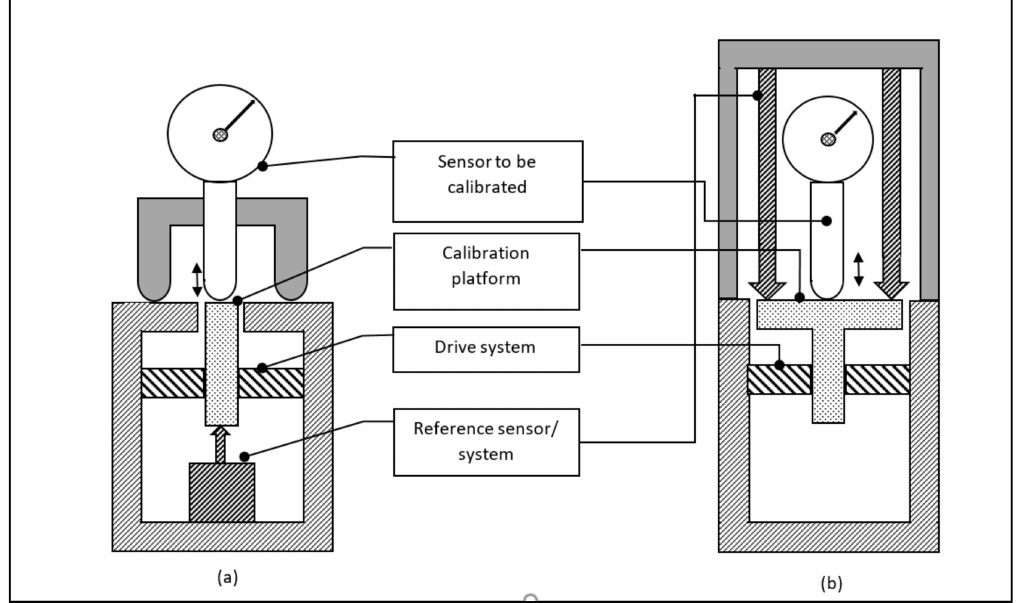
Figure 1. Common calibration set-ups for displacement sensor calibration. In the left-hand side ( a ) the reference sensor detects the displacement of the calibration platform from the other side as the senor to be calibrated, in the right-hand side ( b ) the reference sensor and the sensor to be calibrated detect the displacement of the calibration platform from the same